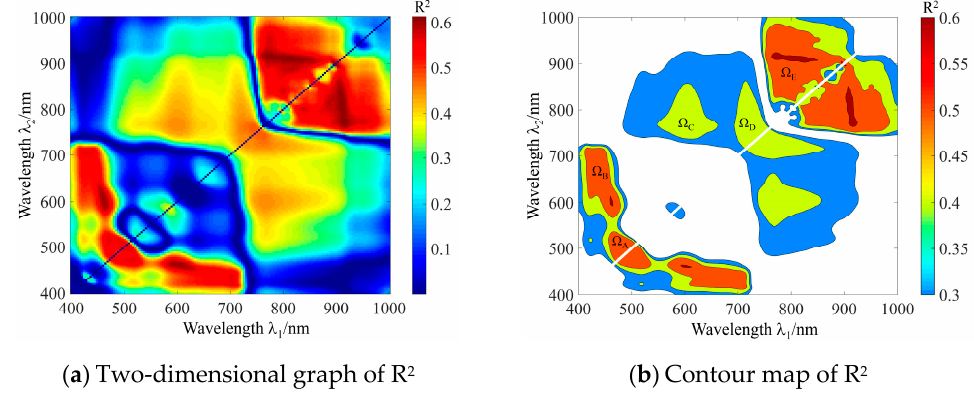
Figure 5. Two-dimensional graph and contour map of the R 2 values between the NDSI and D- f